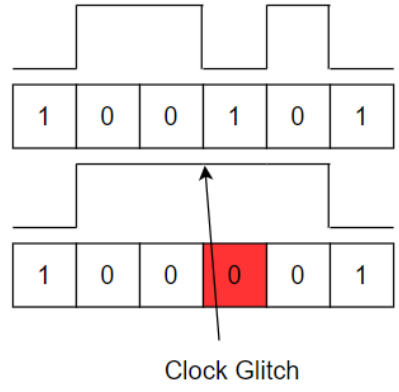
Figure 1. Clock Glitch Fault Injection Attack.